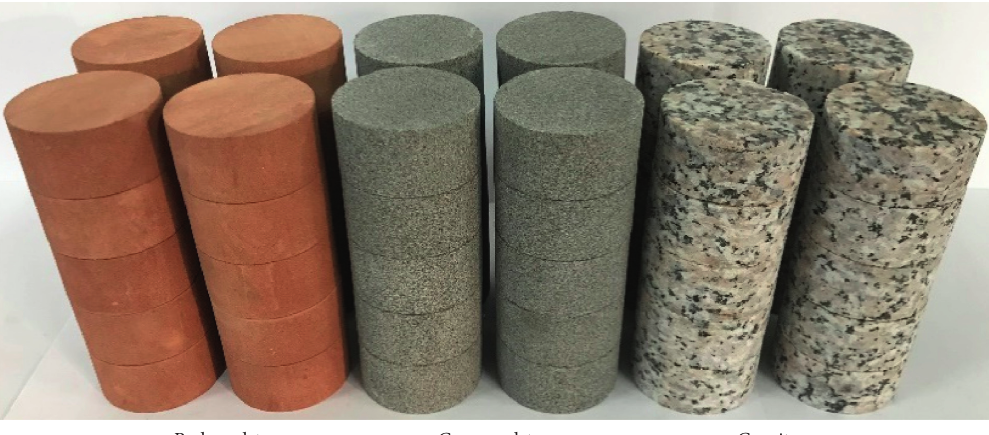
Figure 1: Three kinds of rock samples.